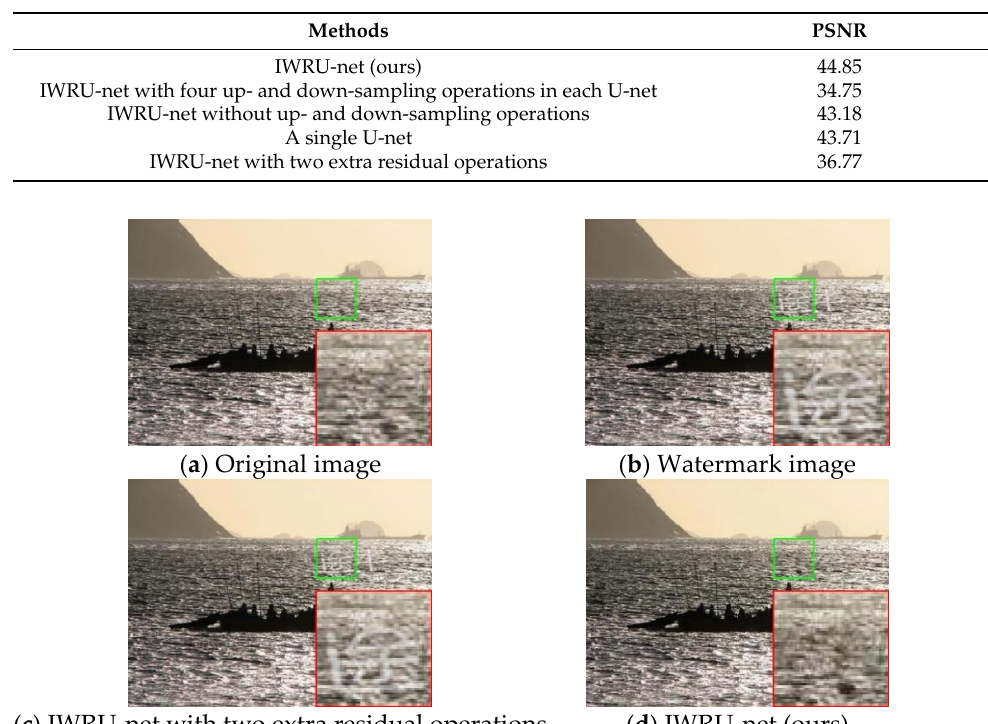
Table 1. PSNR (dB) results of different methods on 100 watermark images from the LVW for image watermark removal.